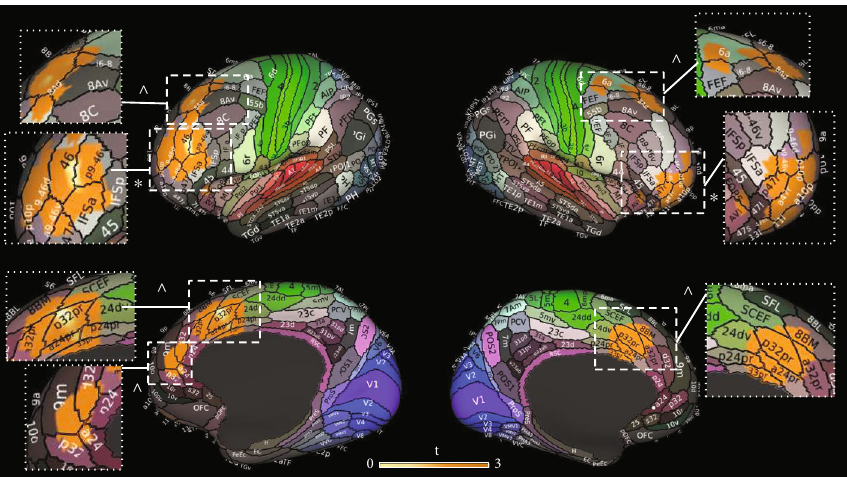
Figure 4: Anatomical mapping of on-target results. Qualitative overlap between the Glasser Atlas and the map of BOLD activations during 40Hz tACS (orange) is shown. Activations on primary target bilaterally ( ∗ ), as well as the secondary impact on regions predicted by the biophysical modeling ( ^ ), such as the ACC and right premotor cortex, are reported.